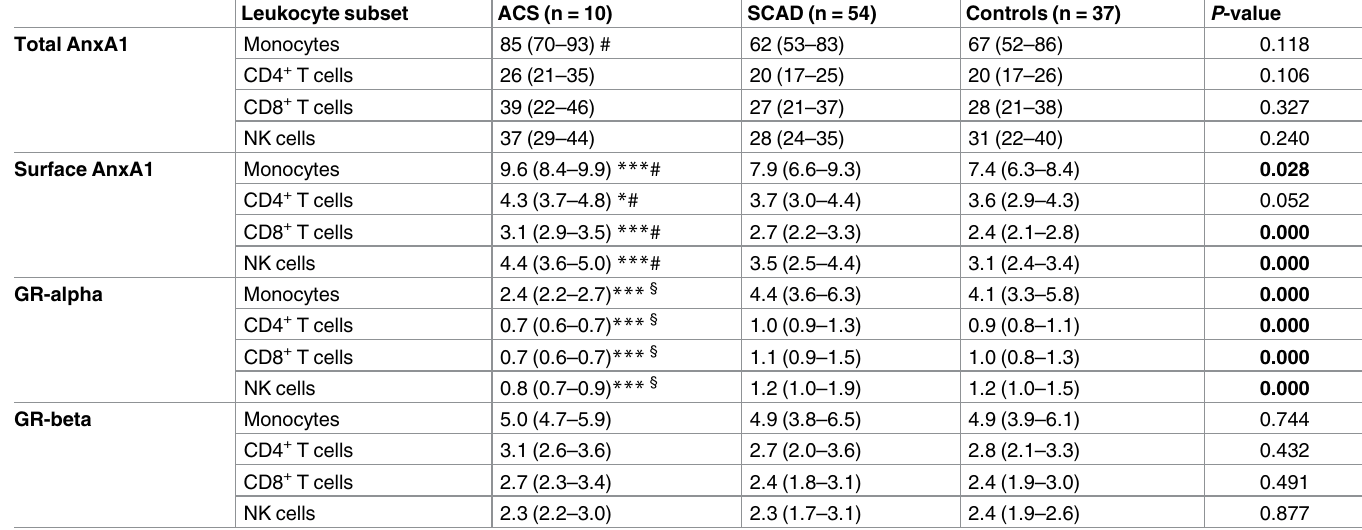
Table 2. Flow cytometric determination of the expression of total AnxA1 (surface+ cytosolic), surfaceAnxA1 and Glucocorticoid Receptor (GR)- alpha and GR-beta in monocytes, CD4 + T cells, CD8 + T cells and NK cells in ACS patients, SCAD patients and controls. Leukocyte subset ACS (n =